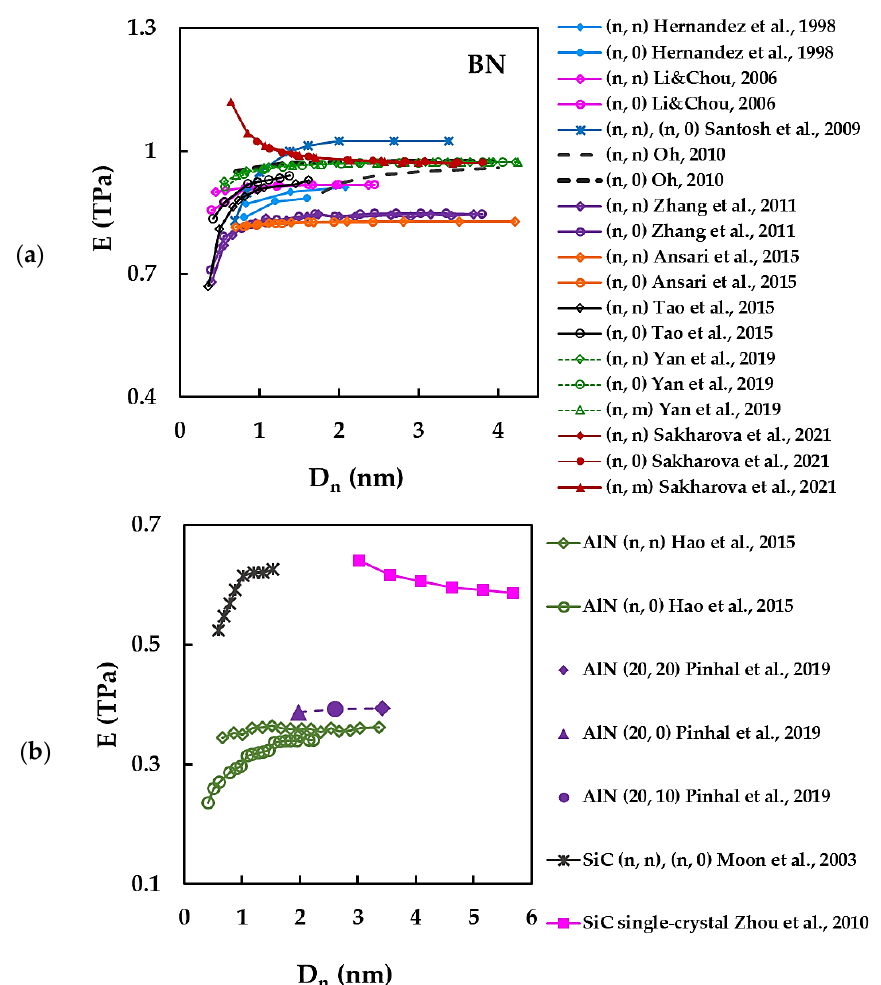
Figure 3. Young’s modulus, E, as a function of nanotube diameter, D n , for ( a ) BNNTs [34,36,56,59–62,66,71] and ( b ) AlNNTs [29,47] and SiCNTs